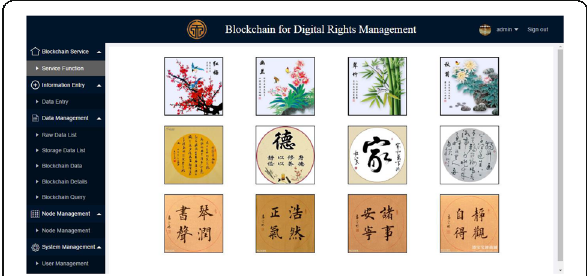
Fig. 8 DRMChain platform service